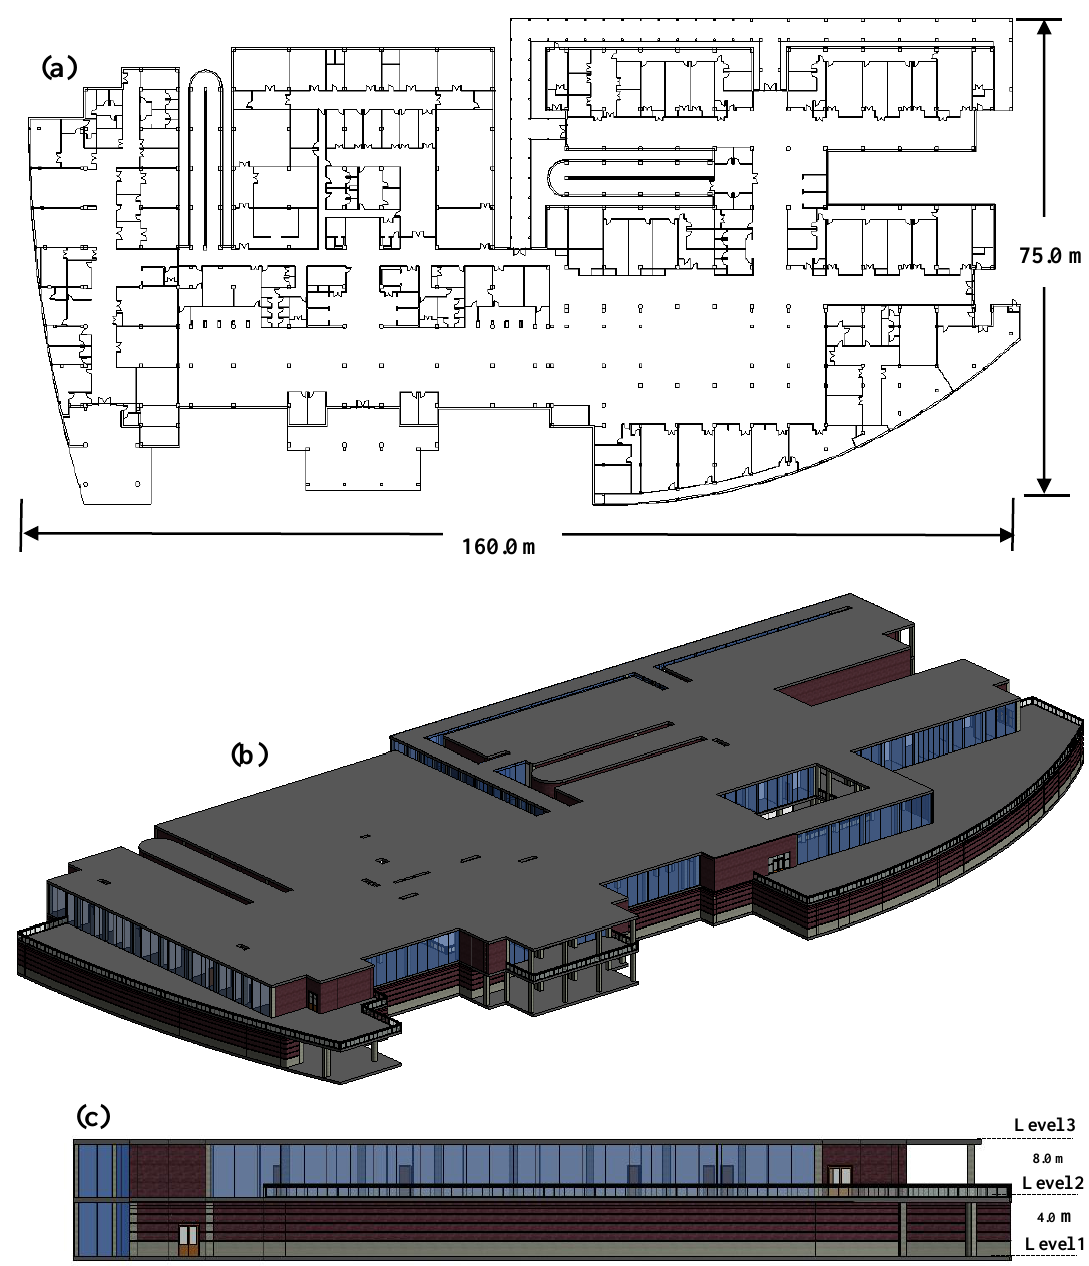
Figure A11. F12 archetype plans and sections: ( a ) Plan view; ( b ) 3-D view for the interior of the hospital; ( c ) 3-D view for the whole hospital.